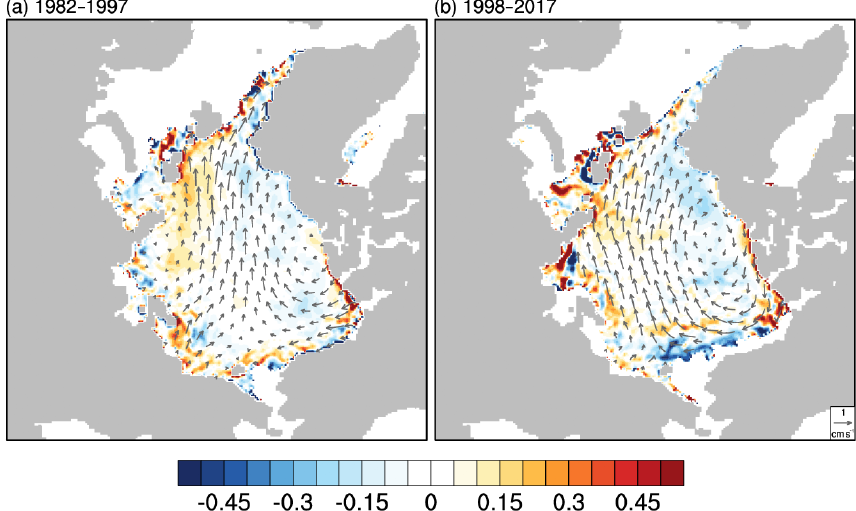
Figure 10. Regressed sea ice motion vector (arrow, cms − 1 ) and its convergence (shaded, 100 per day) onto the AD index in (a) the early (1982–1997) and (b) the recent (1998–2017) period, respectively.